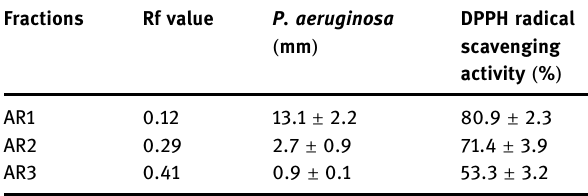
Table 4: Retention factor ( Rf ) values and their corresponding bioactivities of bands collected from preparative TLC of R.